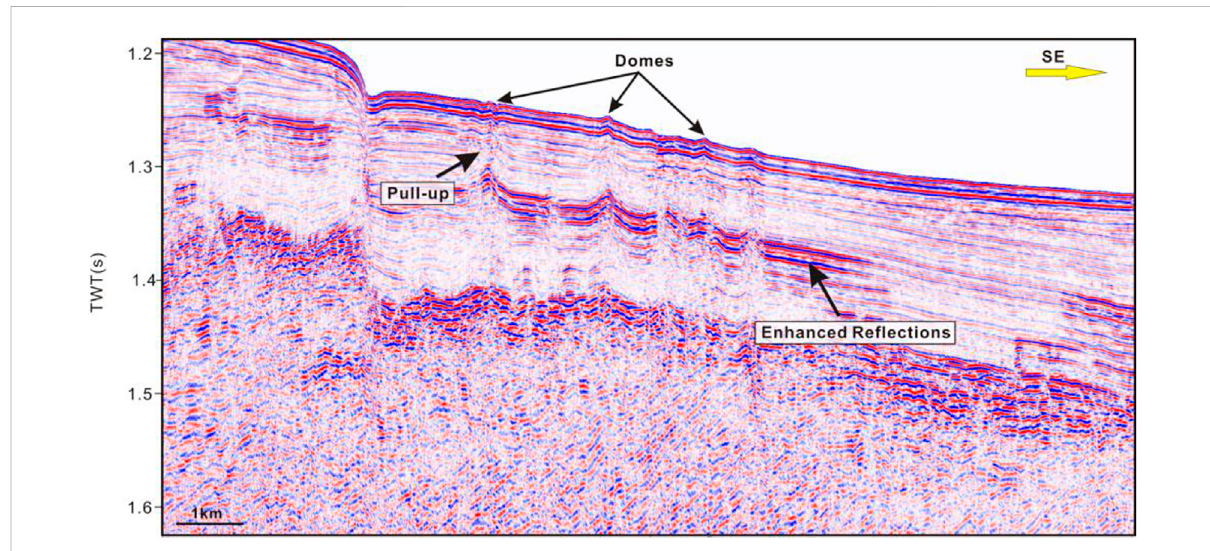
FIGURE 7 Seismic pro fi le shows type-D seismic chimneys. This type of chimney is distinguished by elongated, adjacent to which several enhanced re fl ections have been observed. See locations in Figure